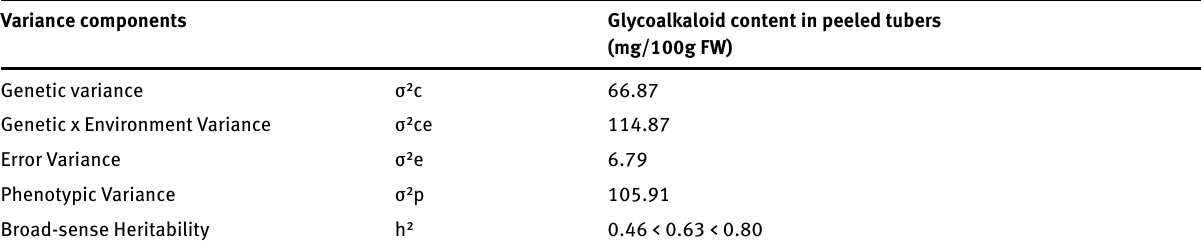
Table 8: Estimates of variance components and broad-sense heritability for glycoalkaloid content Variance